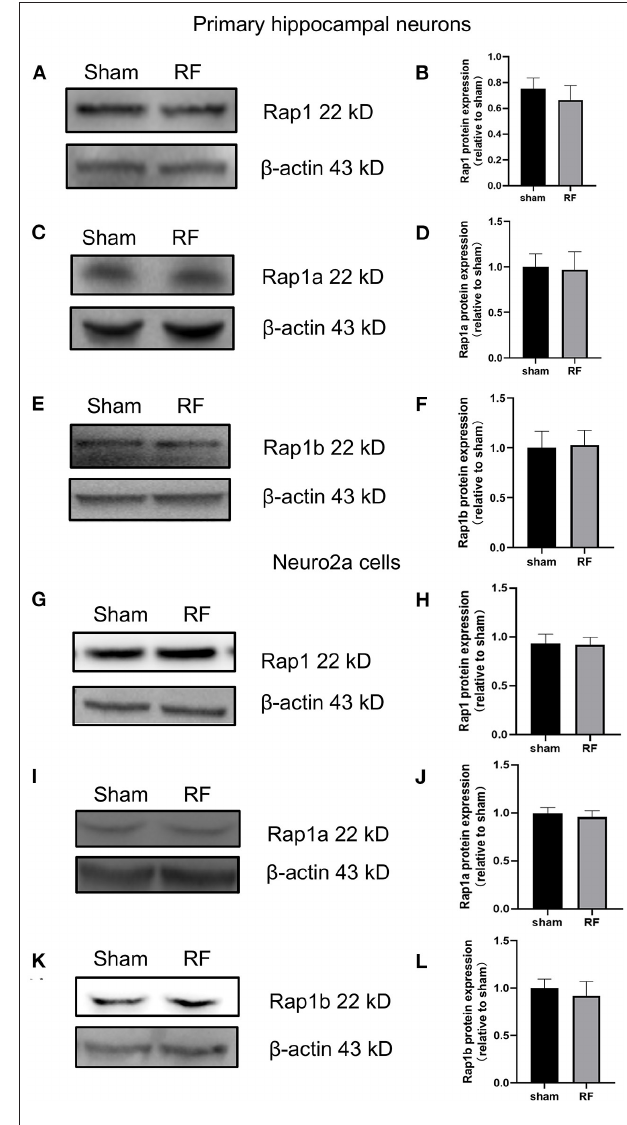
FIGURE 4 | Effects of RF-EMR exposure on the protein expression of Rap1, Rap1a, and Rap1b in neuronal cells. Neuronal cells were exposed to 4 W/kg RF-EMR for 48h. Protein expression was analyzed using western blot analysis. The protein expression levels of Rap1, Rap1a, and Rap1b in primary hippocampal neurons (A–F) and Neuro2a cells (G–L) after RF-EMR exposure.